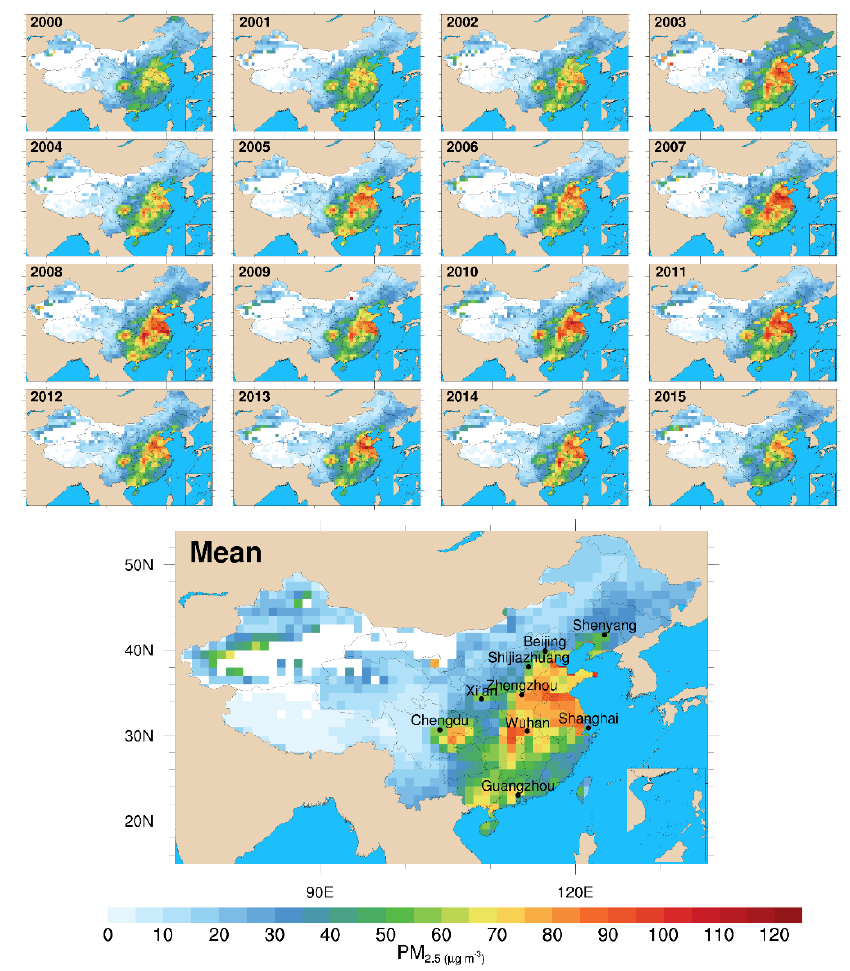
Figure 6. Maps of satellite-derived surface PM 2.5 mass concentrations over China for sixteen years (2000–2015) and, at the bottom, the average over all years. The color bar at the bottom indicates the PM 2.5 concentrations in μ g m − 3 .